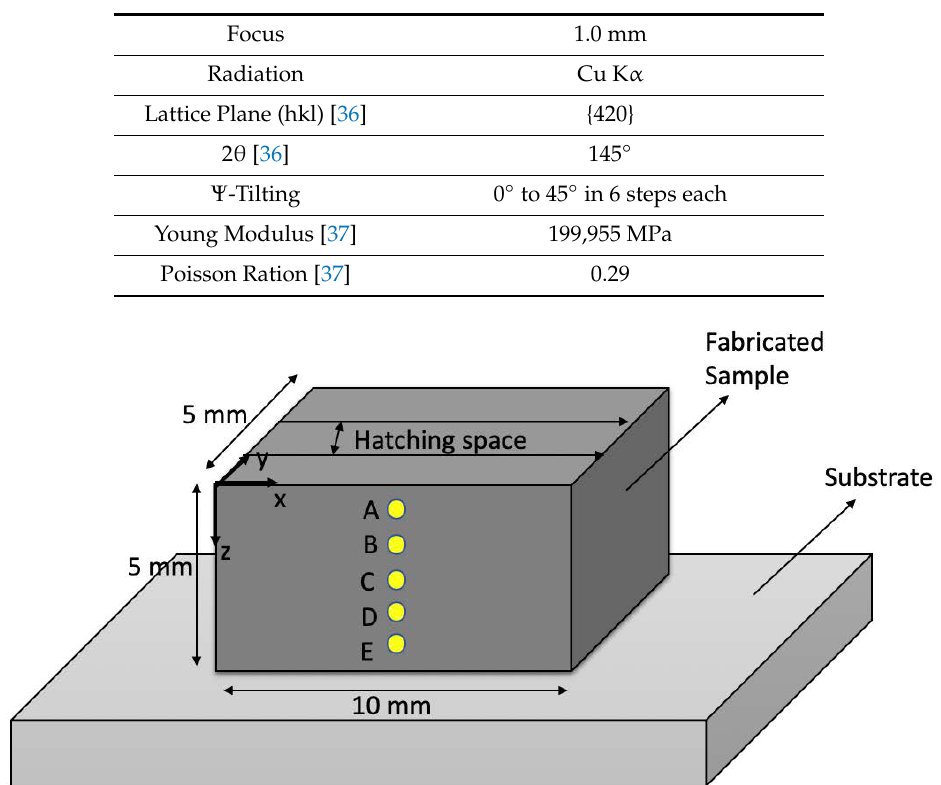
Figure 3. Schematic diagram illustrating the definition of processing parameters.